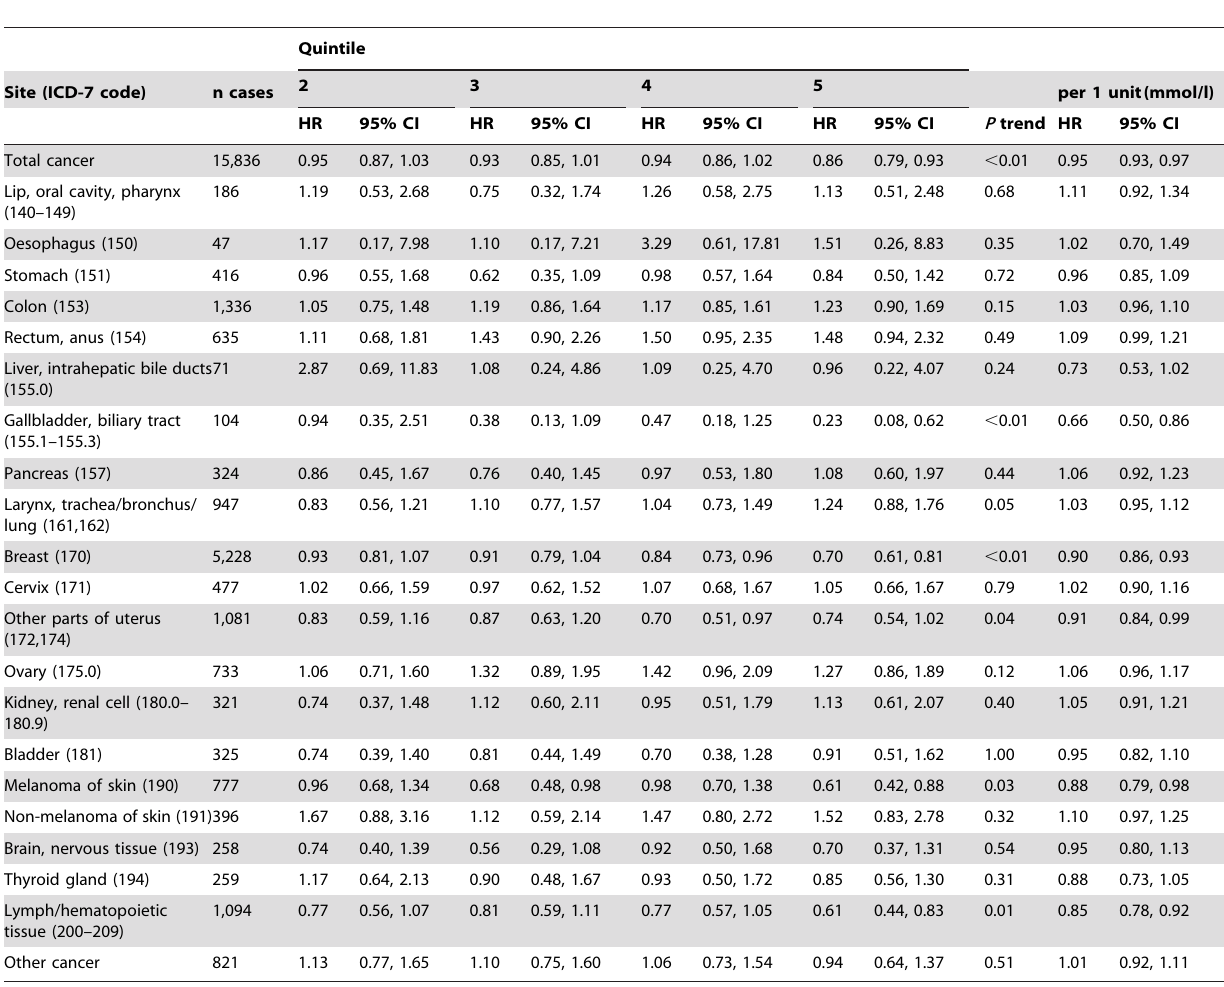
Abbreviations: CI, confidence interval; HR, hazard ratio; ICD-7, International Classification of Diseases, seventh revision. a HRs estimated from Cox proportional hazard regression models with age as the time scale, stratified by cohort, fasting status, and birth year categories, adjusted for baseline age, body mass index categories, and smoking status. HRs corrected for random error by regression dilution ratio (RDR); conversion into uncorrected HR=exp(ln(HR)*RDR), where RDR=0.660.